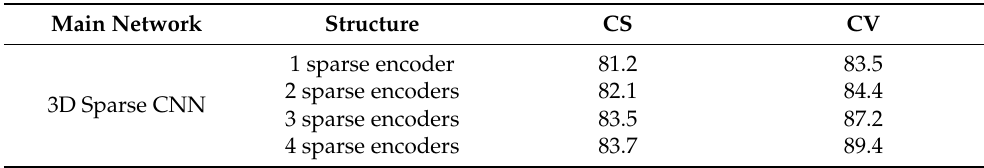
Table 3. Accuracy (%) comparisons on different numbers of layers for the main network on the NTU-RGB+D 60